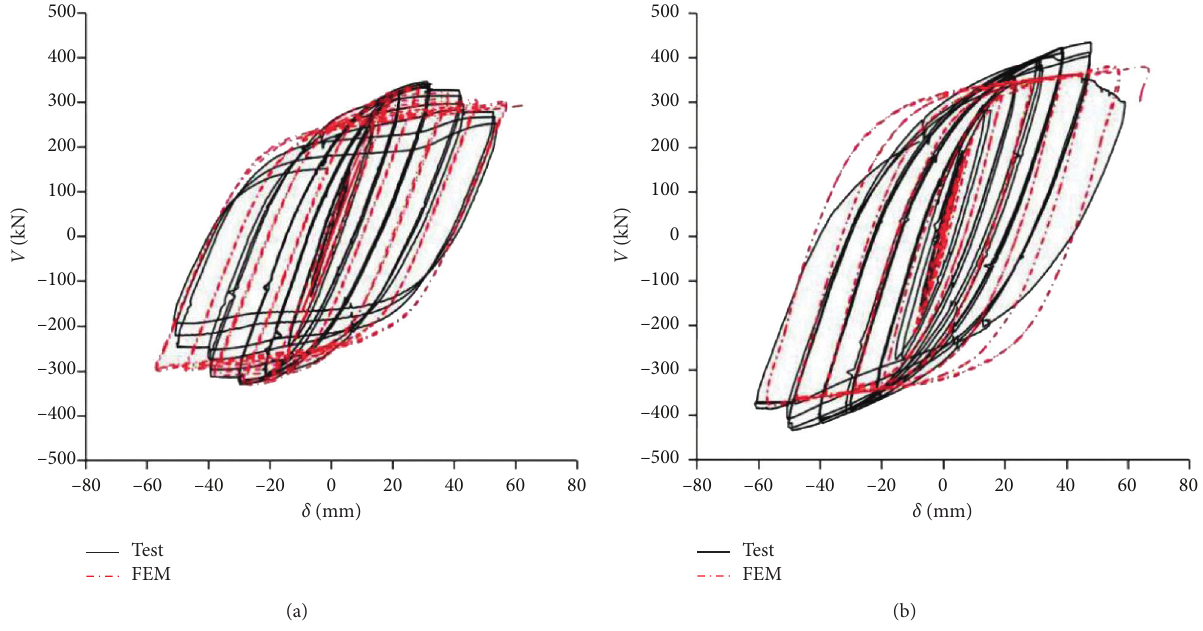
Figure 16: Comparison on hysteretic curves of some pseudostatic specimens. (a) Specimen I-1. (b) Specimen